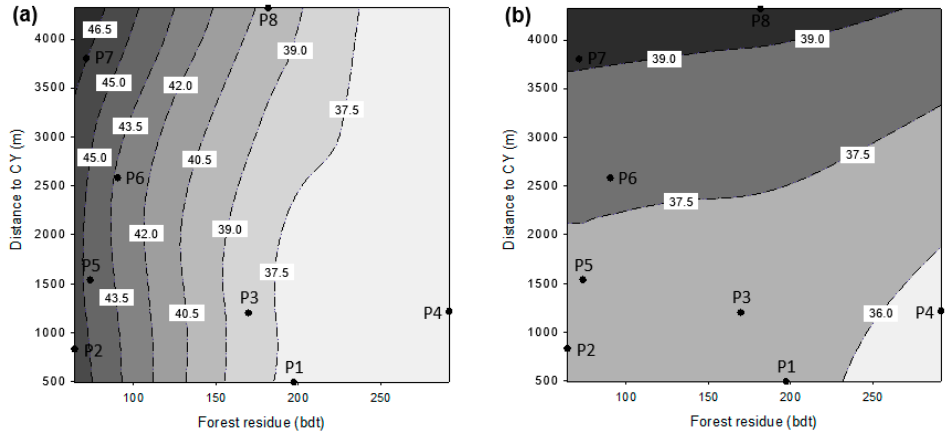
Figure 7. Isocost contour plots of conventional ( a ) and optimized ( b ) logistics costs. These plots present a 3-dimensional relationship with residue volume ( x -axis), distance to concentration yard ( y -axis), and unit cost (grayscale with marked contours). Black dots (P1 through P8) represent pile locations in terms of residue volume and distance to concentration yard. The darker regions indicate higher unit cost and number in the white box shows the unit cost at each contour.